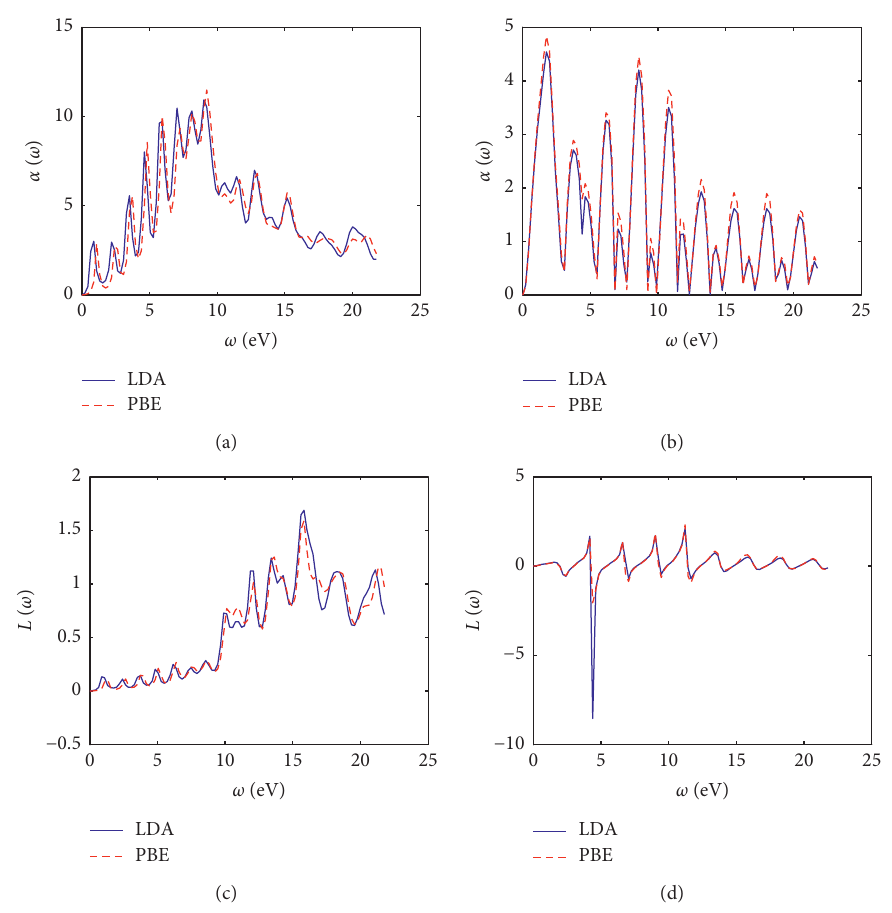
Figure 5: Absorption coefficients for (a) zb-CdS and (b) wz-CdS and energy loss spectrum for (c) zb-CdS and (d)